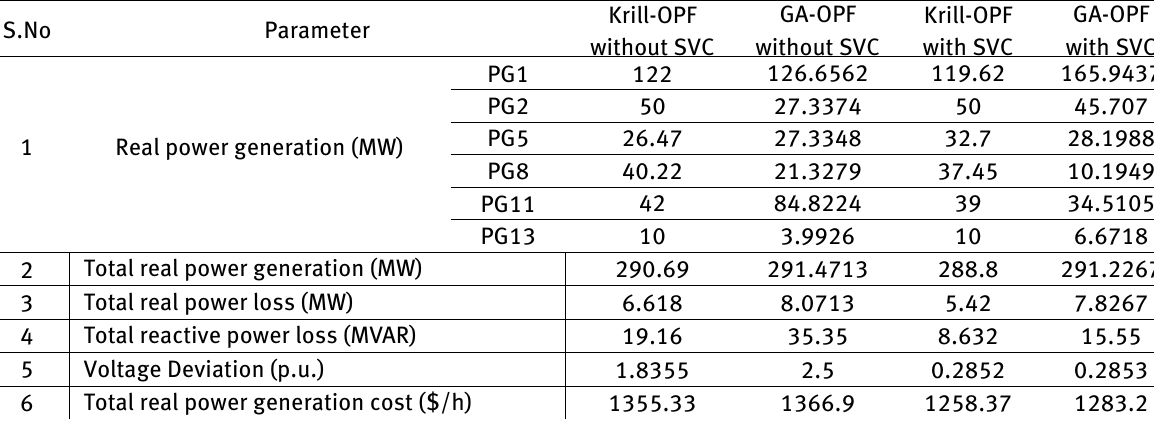
Table 3: Comparison of OPF solution for 30 bus system without and with SVC using Krill-OPF